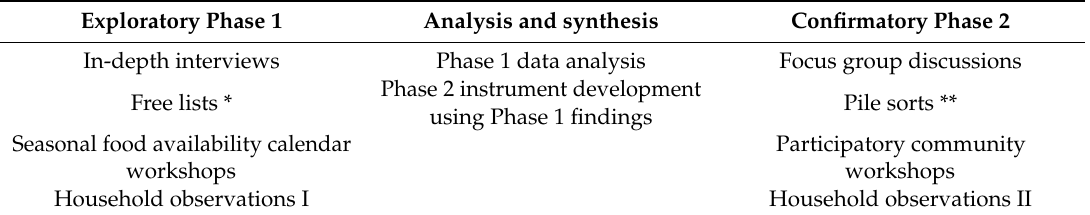
Table 1. Formative study design with data collection methods by study